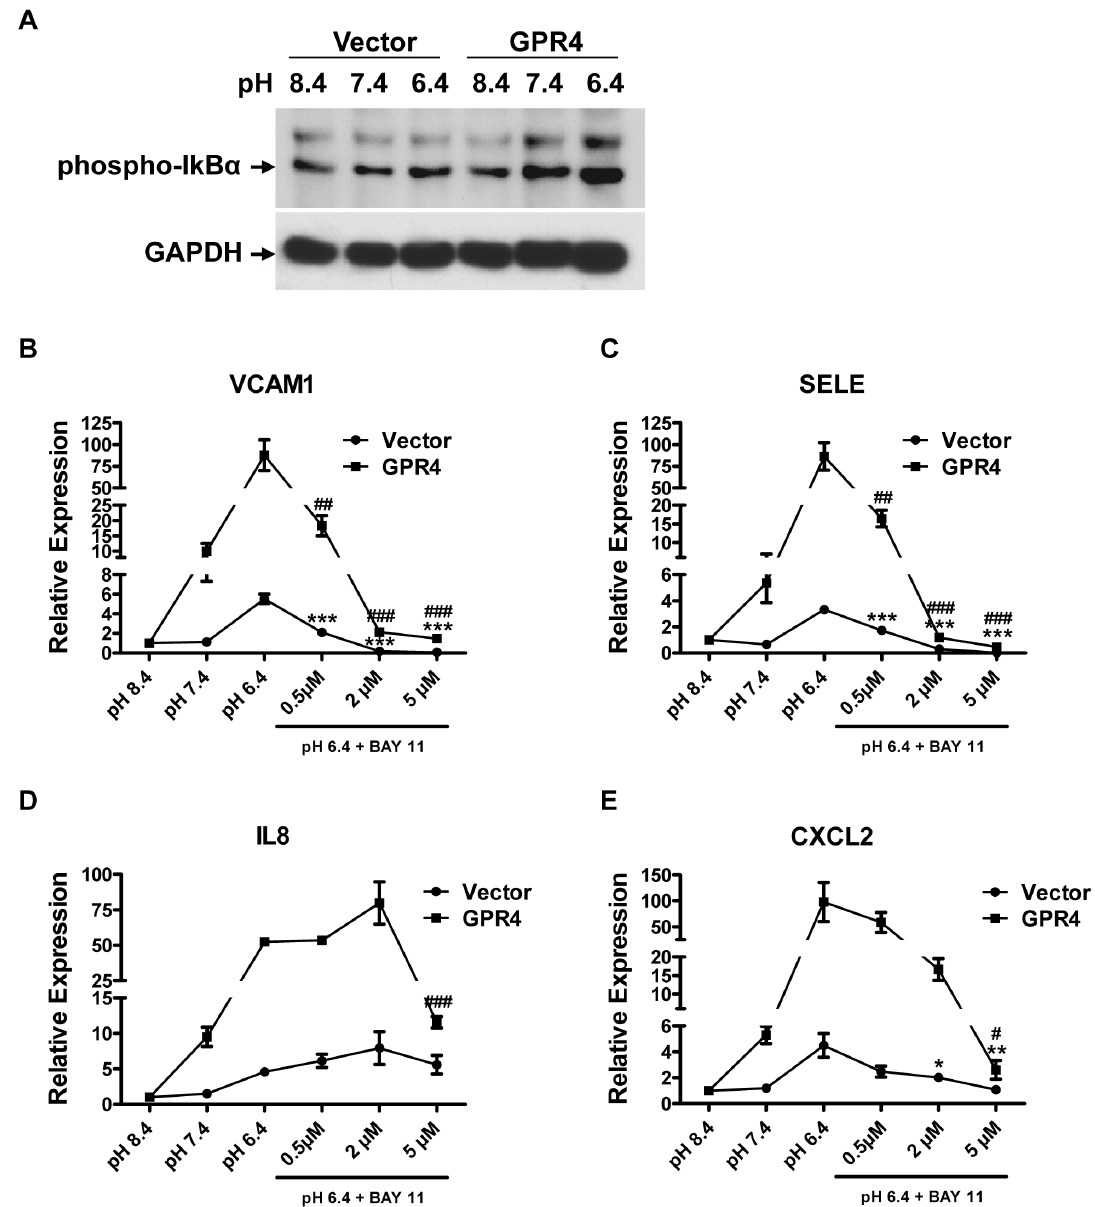
Figure 6. NF- k B pathway is involved in acidosis/GPR4-induced inflammatory response. (A) Western blot of phosphorylated IkB- a expression in HUVEC/Vector and HUVEC/GPR4 cells. Cells were pretreated with EGM-2/HEM pH 8.4 medium for 4 h, followed by the treatment with EGM-2/HEM media at pH 8.4, 7.4, or 6.4 for 3 min. The target bands are indicated by an arrow. Western blot of GAPDH serves as a loading control. (B– E) HUVEC/Vector or HUVEC/GPR4 cells were treated for 5 h with EGM-2/HEM pH 8.4, 7.4 or 6.4 media, or with pH 6.4 media containing indicated concentrations of NF- k B inhibitor BAY 11-7082. Total RNA was isolated and cDNA was synthesized. Real-time RT-PCR quantification of gene expression of VCAM1 (B), SELE (C), IL8 (D) and CXCL2 (E) was performed. Ct values were normalized to the housekeeping gene GAPDH. The expression level of the target genes at pH 8.4 was set as 1. Error bars indicate the mean 6 SEM. *, P , 0.05; **, P , 0.01; ***, P , 0.001; compared with the pH 6.4 vehicle control in HUVEC/Vector cells. # , P , 0.05; ## , P , 0.01; ### , P , 0.001; compared with the pH 6.4 vehicle control in HUVEC/GPR4 cells. The results shown are the average of at least three biological repeats.